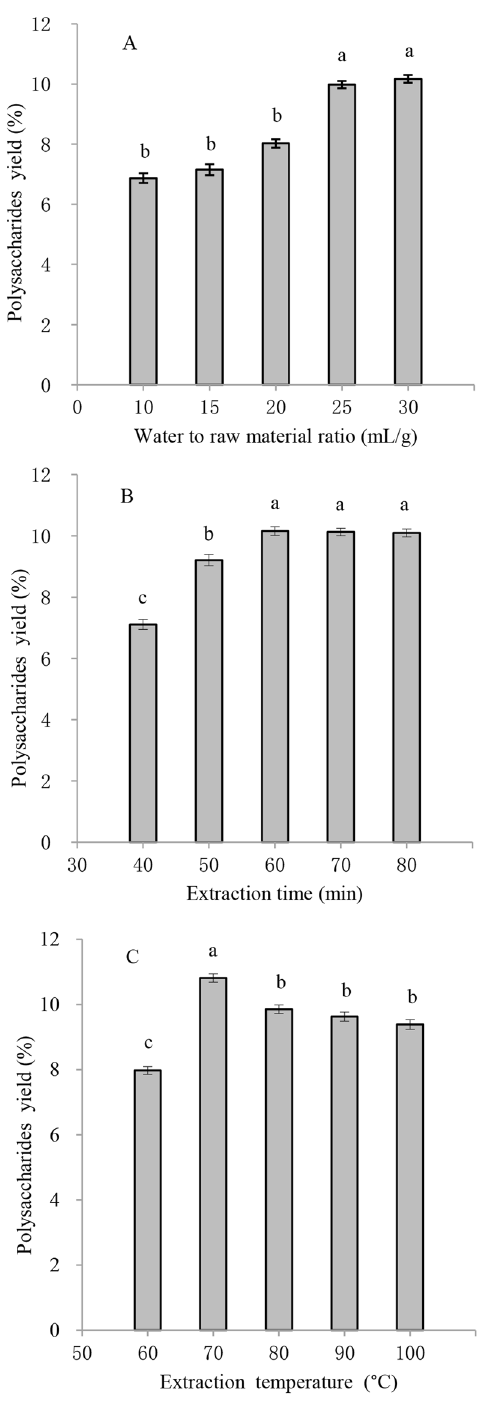
Figure 1. Influences of water to raw material ratio (A) , extraction time (B) and extraction temperature (C) on the extraction yield of Astragalus cicer L. polysaccharides. Bar charts with different lowercase letters significantly differ ( P <